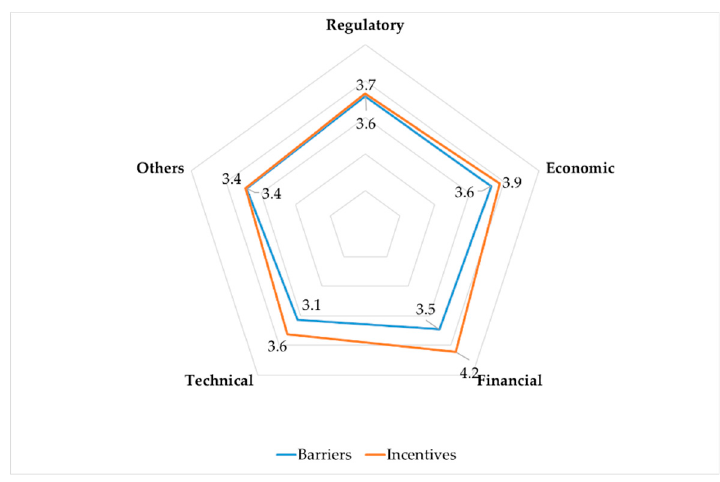
Figure 1. Aggregated rating in typologies of barriers and incentives.